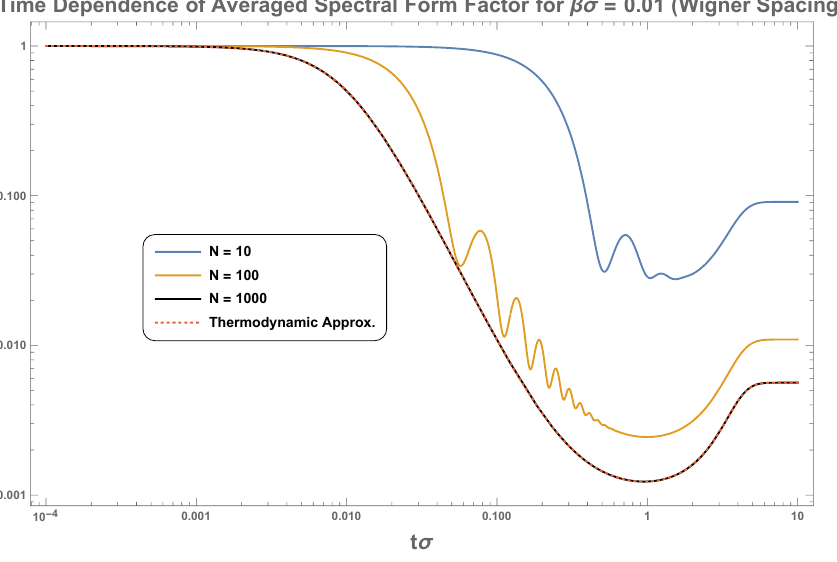
Figure 6 . Above is a Log-Log plot of the averaged spectral form factor of a spectrum generated by the i.i.d model with Wigner surmise NNS distribution for the GUE given by eq. (3.13). The temperature is fixed at βσ = 0 . 01 and we vary N .